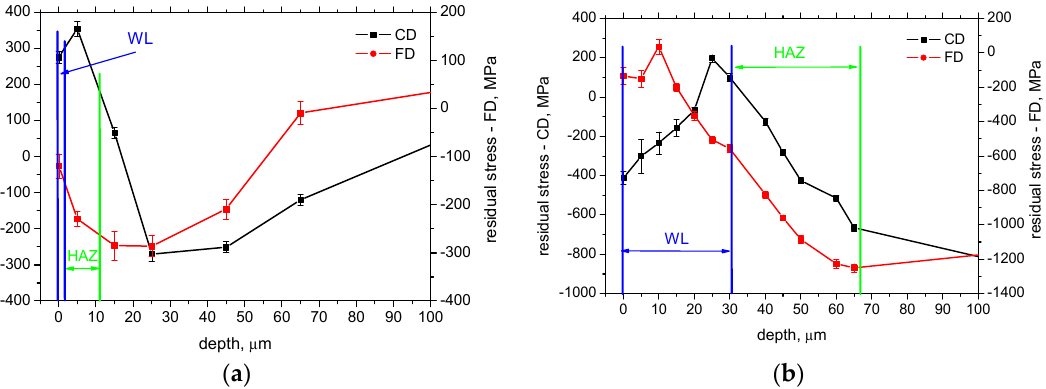
Figure 8. Details of residual stress depth profiles for cutting speed 100 m.min − 1 . ( a ) VB = 0.1 mm, ( b ) VB = 0.8 mm.